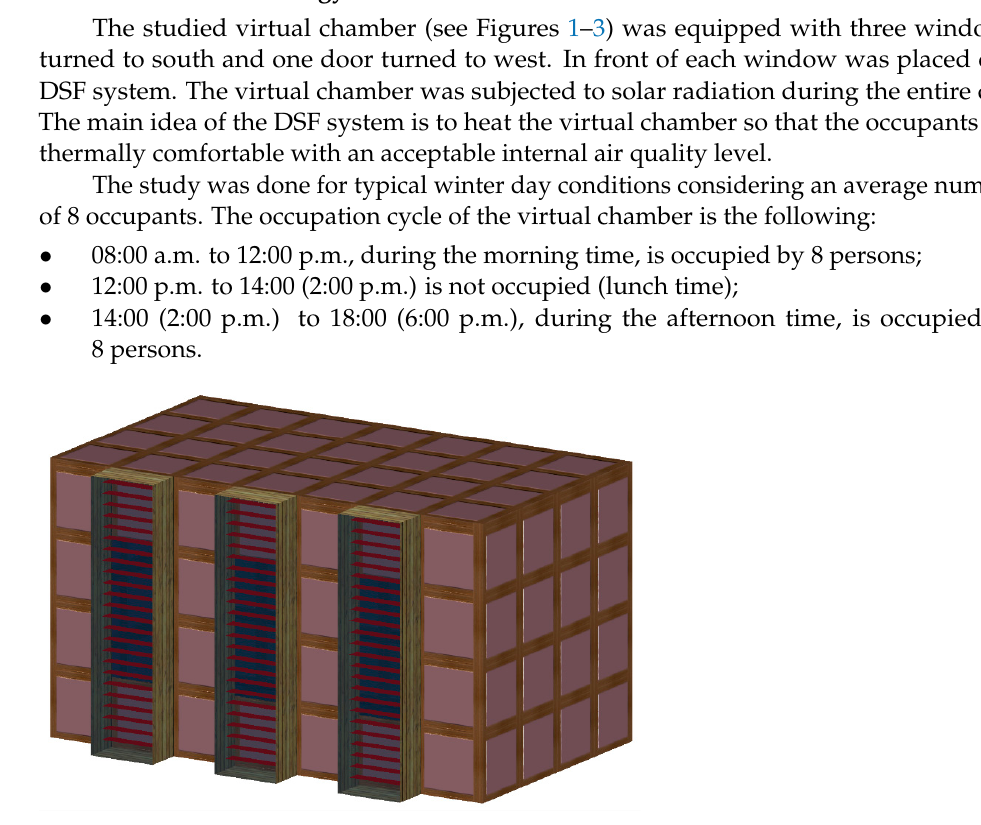
Figure 1. Compartment, double skin facade (DSF) structure, DSF glasses and Venetian-type blinds.